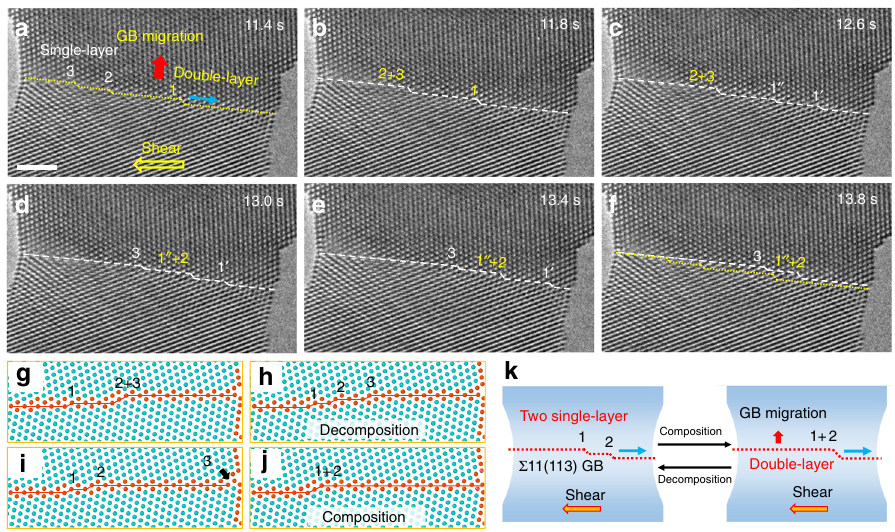
Fig. 3 Composition and decomposition of disconnections during GB migration. a A Σ 11(113) coherent GB with the co-existence of two single-layer disconnections (denoted as 2 and 3, respectively) and a double-layer disconnection (denoted as 1). The directions of shear stress, disconnection motion and GB migration are indicated with the yellow, blue and red arrows, respectively. b Composition of single-layer disconnections 2 and 3 into a double-layer disconnection (2 + 3) under shear loading, while the double-layer disconnection 1 remained almost static. c Decomposition of the double-layer disconnection 1 into two single-layer ones 1 ′ and 1 ″ . d Decomposition of the double-layer disconnection (2 + 3) into two single-layer ones (2 and 3), followed by prompt composition of 2 and 1 ″ into a new double-layer disconnection (1 ″ + 2). e , f Lateral motion of the disconnections and the annihilation of disconnection 1 ′ at the free surface, resulting in the upward migration of the Σ 11(113) coherent GB. The yellow dotted lines and white dashed lines represent the initial and current positions of the GB, respectively. g – j MD simulation snapshots performed at 0 K by the energy minimisation, demonstrating the dynamic processes of ( h ) decomposition of a double-layer disconnection (2 + 3), i subsequent surface annihilation of a single-layer disconnection 3 and ( j ) composition of the single-layer disconnections 1 and 2 into a double-layer disconnection. k Schematic illustrating the composition and decomposition between the single-layer and double-layer disconnections. Scale bar: 2